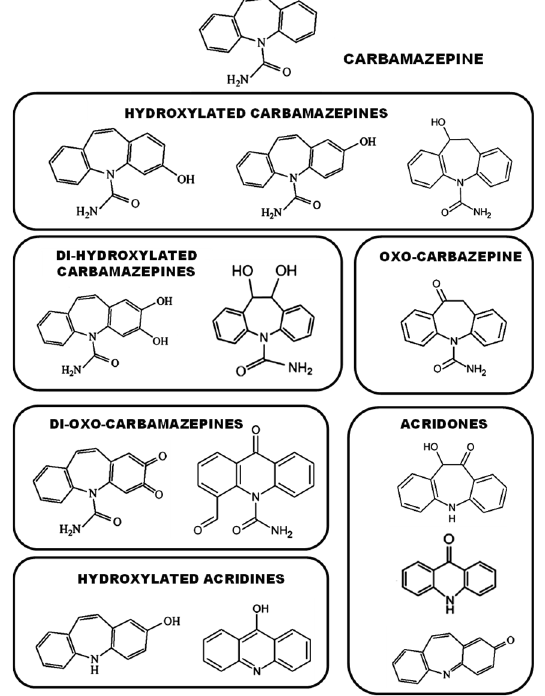
Figure 5. Reaction intermediates causing colour in oxidised carbamazepine solutions.